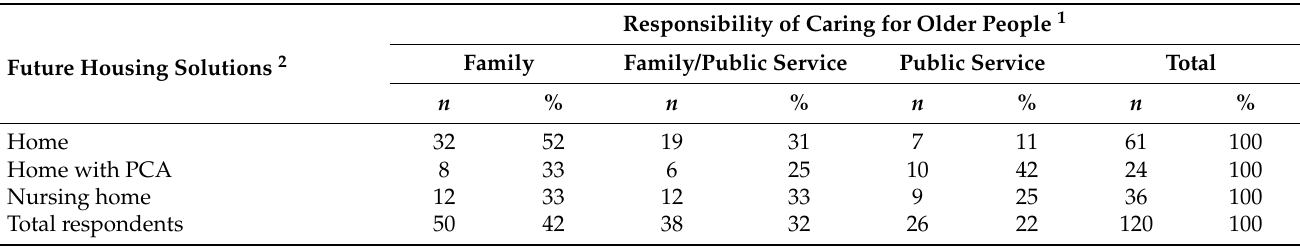
Table 7. Future housing solutions and family/public responsibility of caring for older people ( n ;